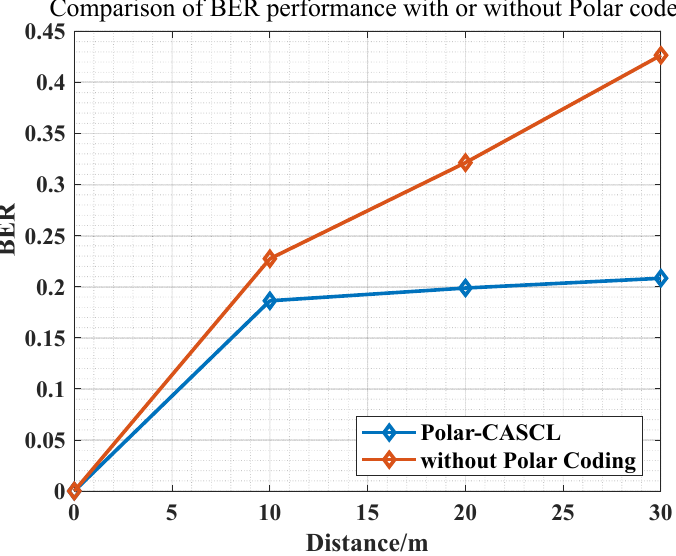
Figure 5. Performance comparison of bit error rate under weak ocean turbulence (C 2 n = 1.0 × 10 − 15 K 2 m − 2/3